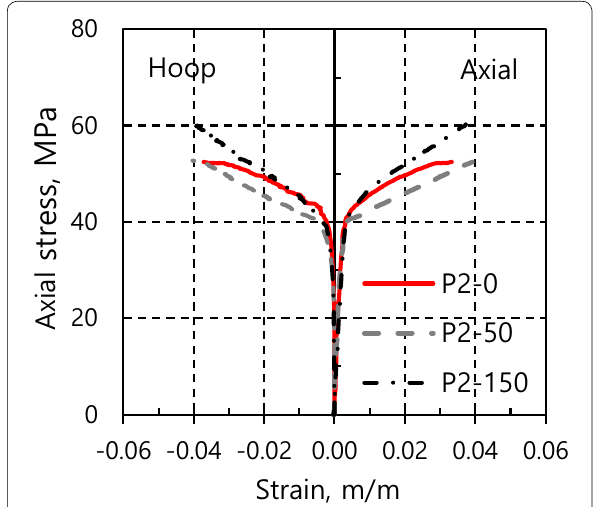
Fig. 13 Stress-strain relationship: additional confinement